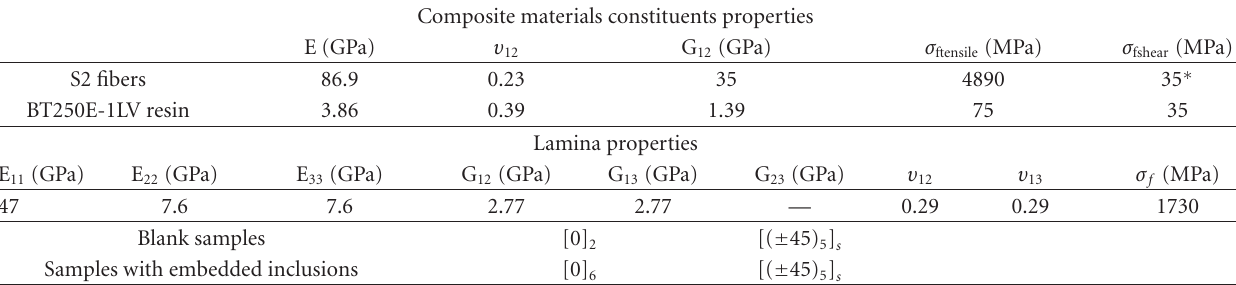
Table 2: S2/BT250E-1LV material properties and lay-ups. ∗